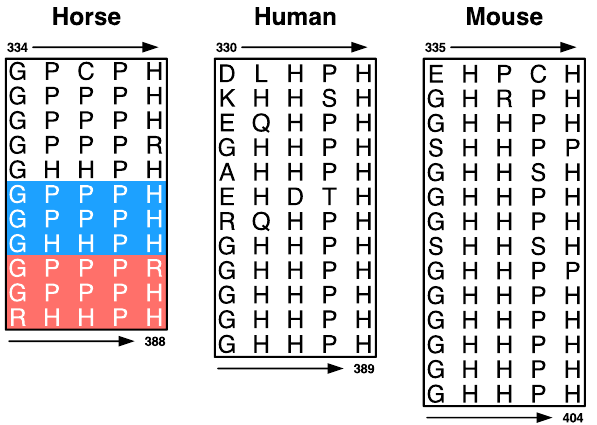
Figure 3. Amino acid sequence of HRR in horse, human, and mouse HRG gene. Different types of tandem repeats in the HRR of HRG gene are found. Amino acid sequences vary among 3 species. Alphabets in the figure indicate the symbols for the various amino acids. 45 bp deletion: red highlighting area; 90 bp deletion: blue and red highlighting area. The GenBank accession numbers are as follows: human, NP_000403; mouse, NP_444406.